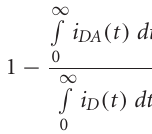
unlabeled phospholipid, were mixed. The chosen FRET pair was composed of the labeled phospholipids N -(7-nitro-2,2,3- benzoxadiazol-4-yl)-phosphatidylethanolamine (NBD-PE,